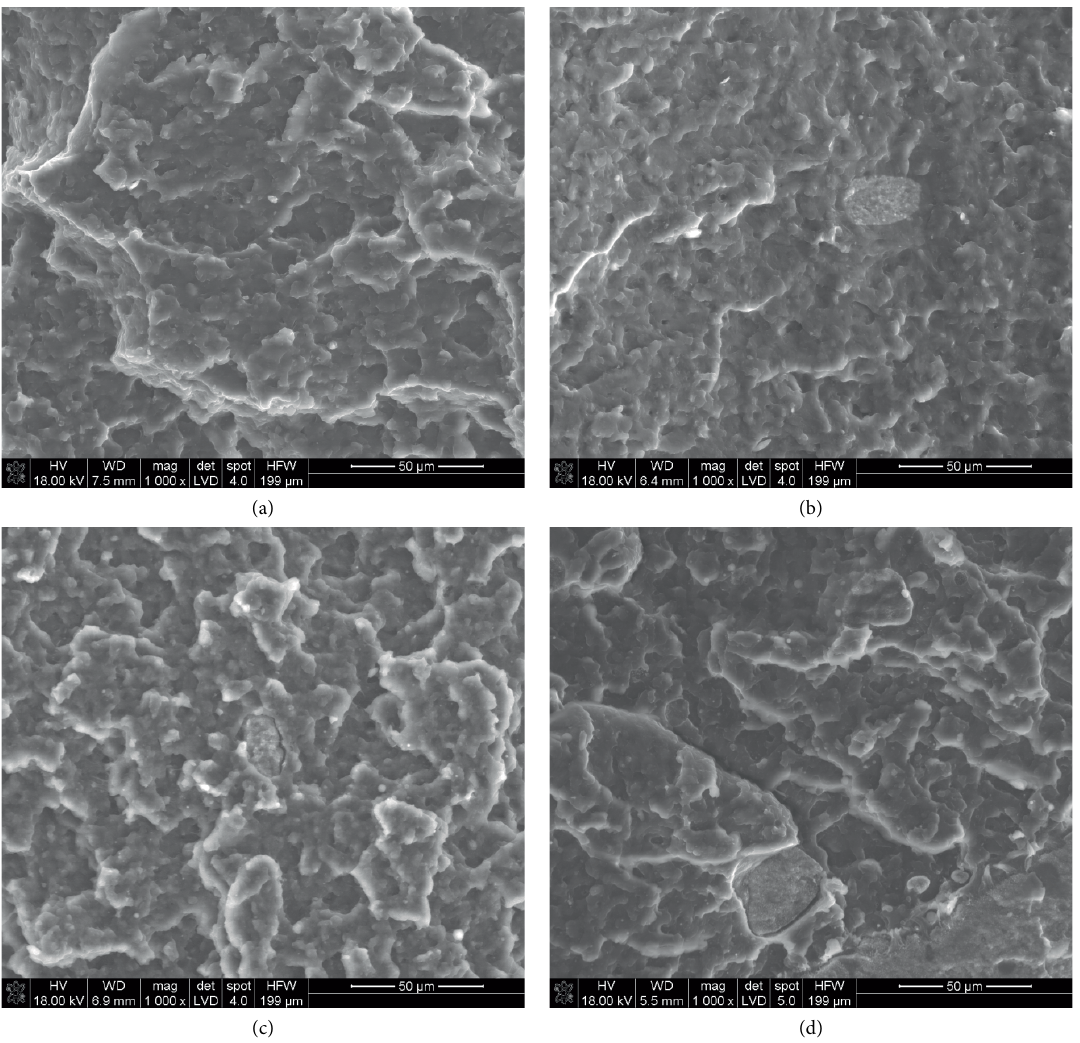
Figure 10: SEM images of cryogenically fractured surfaces of POM (a), POM/1.0% HA- g -PEG 600 (b), POM/1.0% HA- g -PEG 2000 (c), POM/1% HA- g -PEG 6000 (d) (mag.